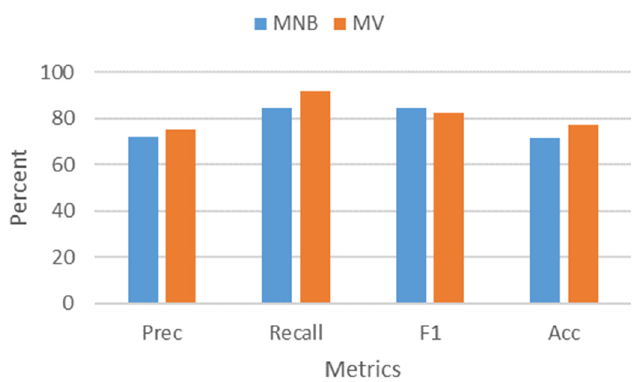
Figure 4. Performance of MNB vs. MV.